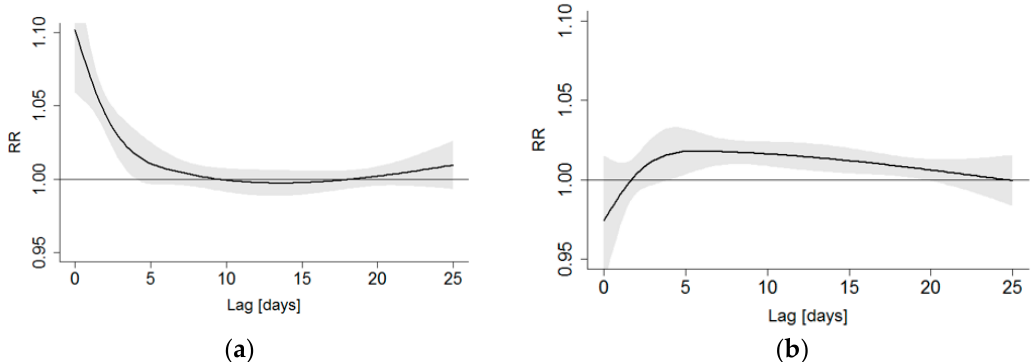
Figure 5. Examples of the effects of lag on relative mortality risk (RR) at two different temperatures, ( a ) Tavg = 24 °C, representing heat stress and ( b ) Tavg = − 20 °C, cold stress. Examples of all-aged mortality in HD1, Helsinki–Uusimaa hospital district. DLNM with 3 knots for temperature and 2 for lag. Tavg: spatially averaged daily mean temperature. Table 2. Comparison of the relative mortality risk, RR (95% CI), in HD1 and HD12 at selected temperatures in three model versions: pooled model without lag and seasonal variation, a simple model without lag and seasonal variation, a DLNM with 25-day lag and seasonal variation.